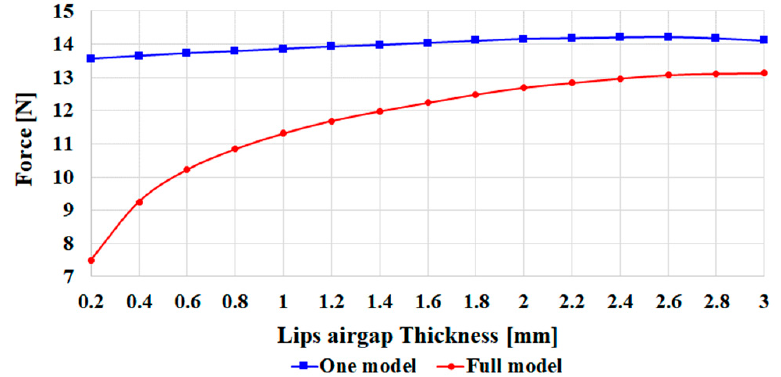
Figure 9. x -axis force graph for lip thickness of the full model and the one-module model.